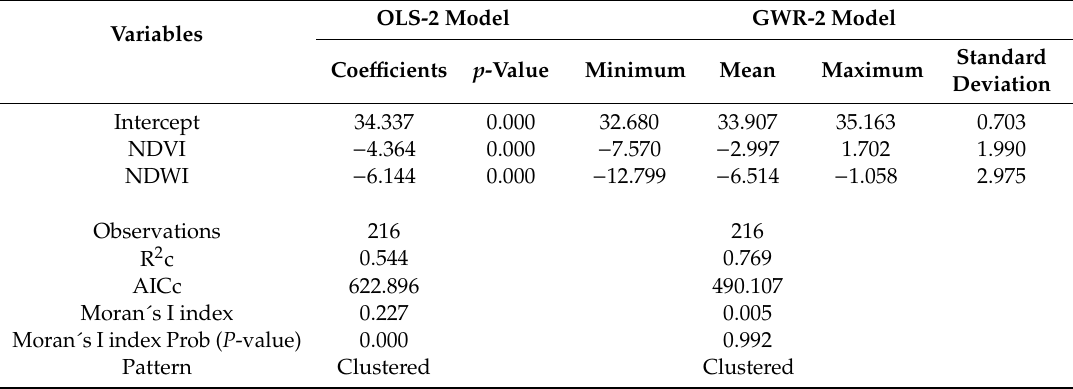
Table 2. Results for the second OLS and GWR regression